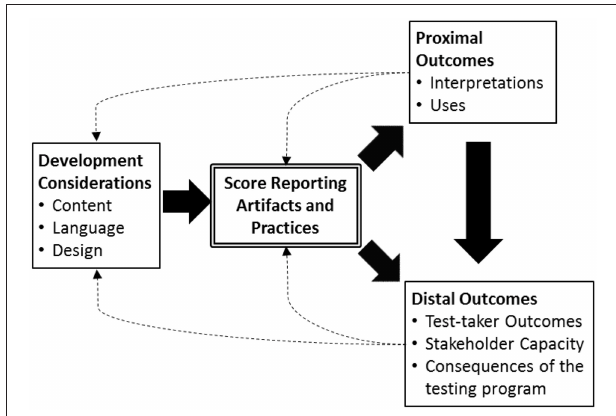
FIGURE 1 | A logic model representing the production of score reports and associated outcomes of